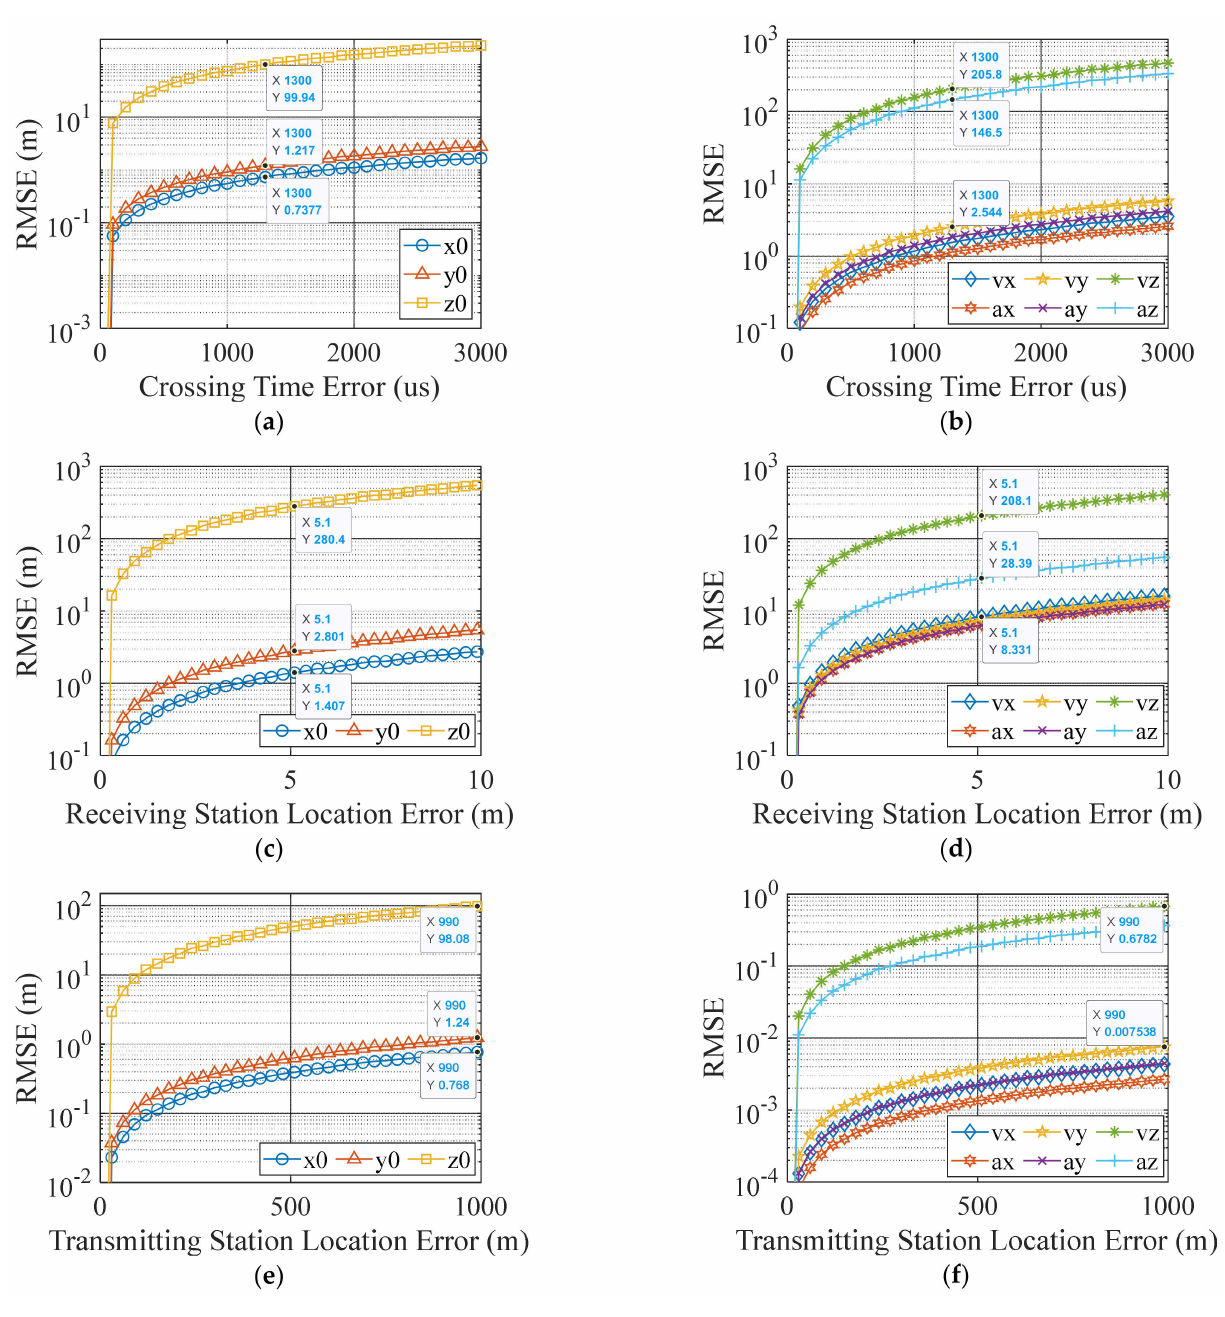
Figure 3. Influence of error sources on parameter estimation accuracy. ( a ) Initial position estimation. ( b ) Velocity and acceleration estimation. ( c ) Initial position estimation. ( d ) Velocity and acceleration estimation. ( e ) Initial position estimation. ( f ) Velocity and acceleration